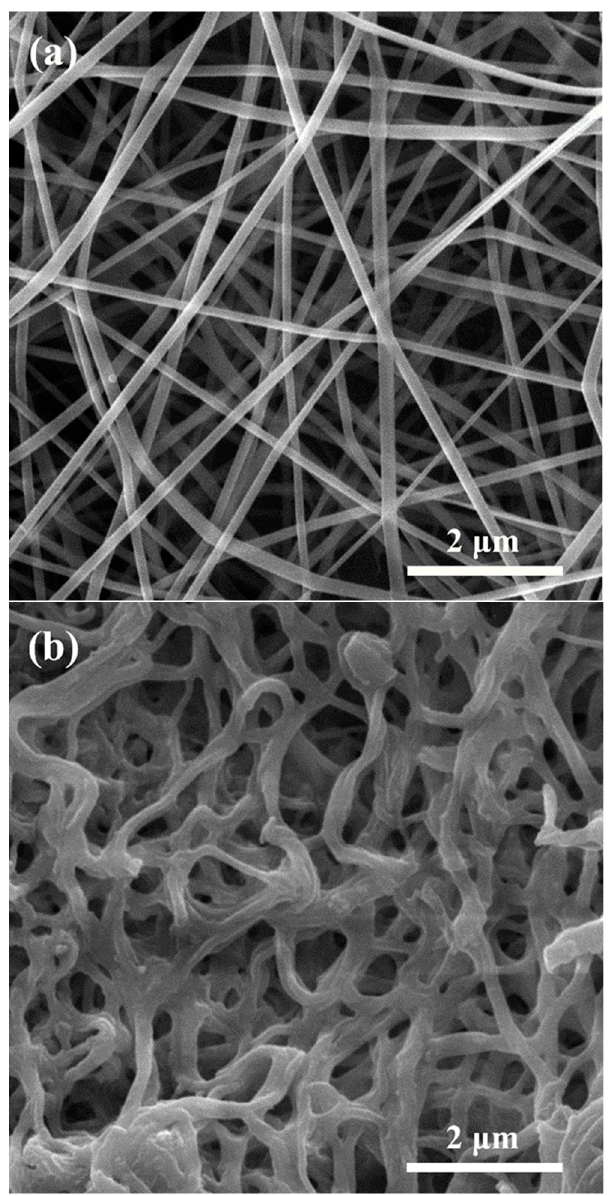
Figure 3. SEM images of ( a ) PVA/SCFG precursor fibers; ( b ) SCFG fibers after calcination at 950 °C for 5 h.